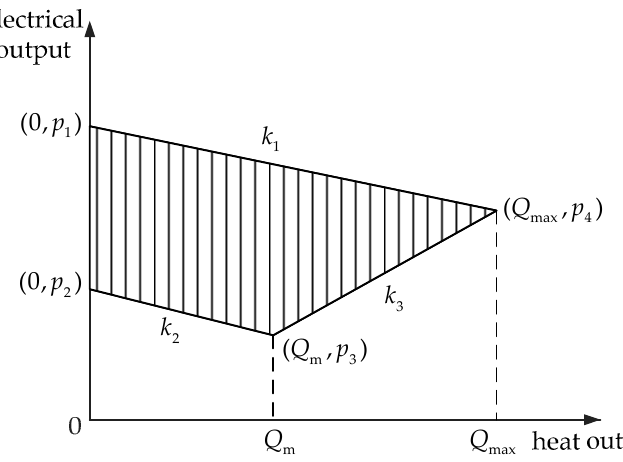
Figure 2. The output feasible range of the combined heat and power (CHP) unit.